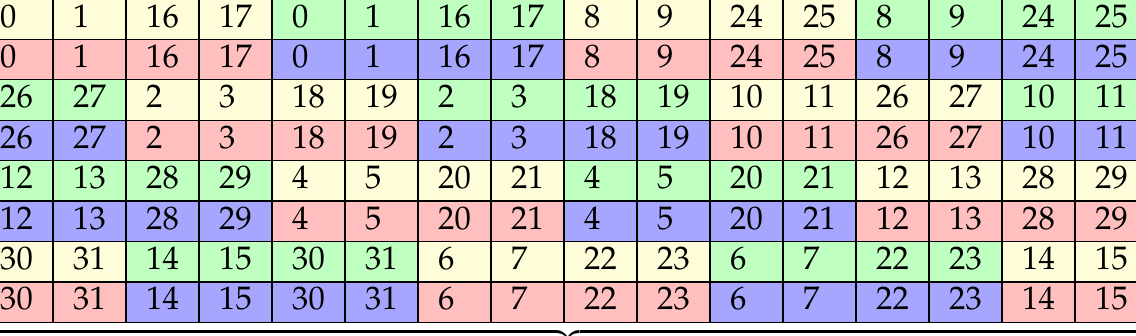
Figure 8. optSTS64 compact